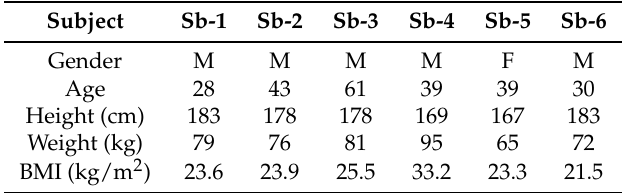
Table 2. Characteristics of the subjects participating in calibration measurements.